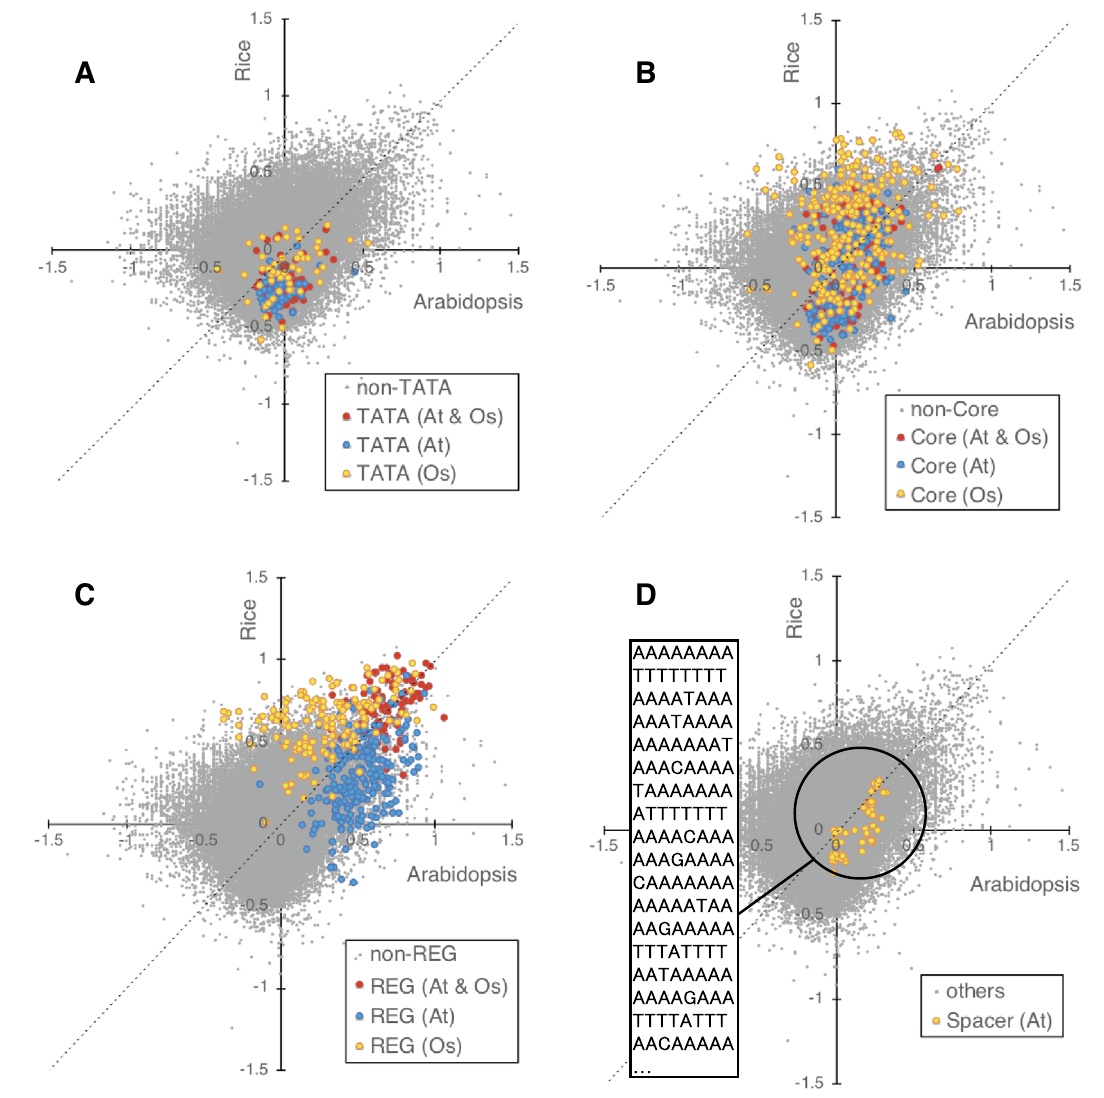
Figure 8. PRI score of promoter constituents in Arabidopsis and rice. Horizontal and vertical axes are PRI of Arabidopsis and rice, respectively. All the octamer sequences are presented in gray dots, and highlighted with color for several categories of promoter constituents: ( A ) TATA, ( B ) Core elements (TATA, Y Patch, GA, and CA), ( C ) REG (Regulatory Element Group), ( D ) Spacer sequences in Arabidopsis which are the most frequently occurring octamers in the promoter region excluding functional elements (REG and